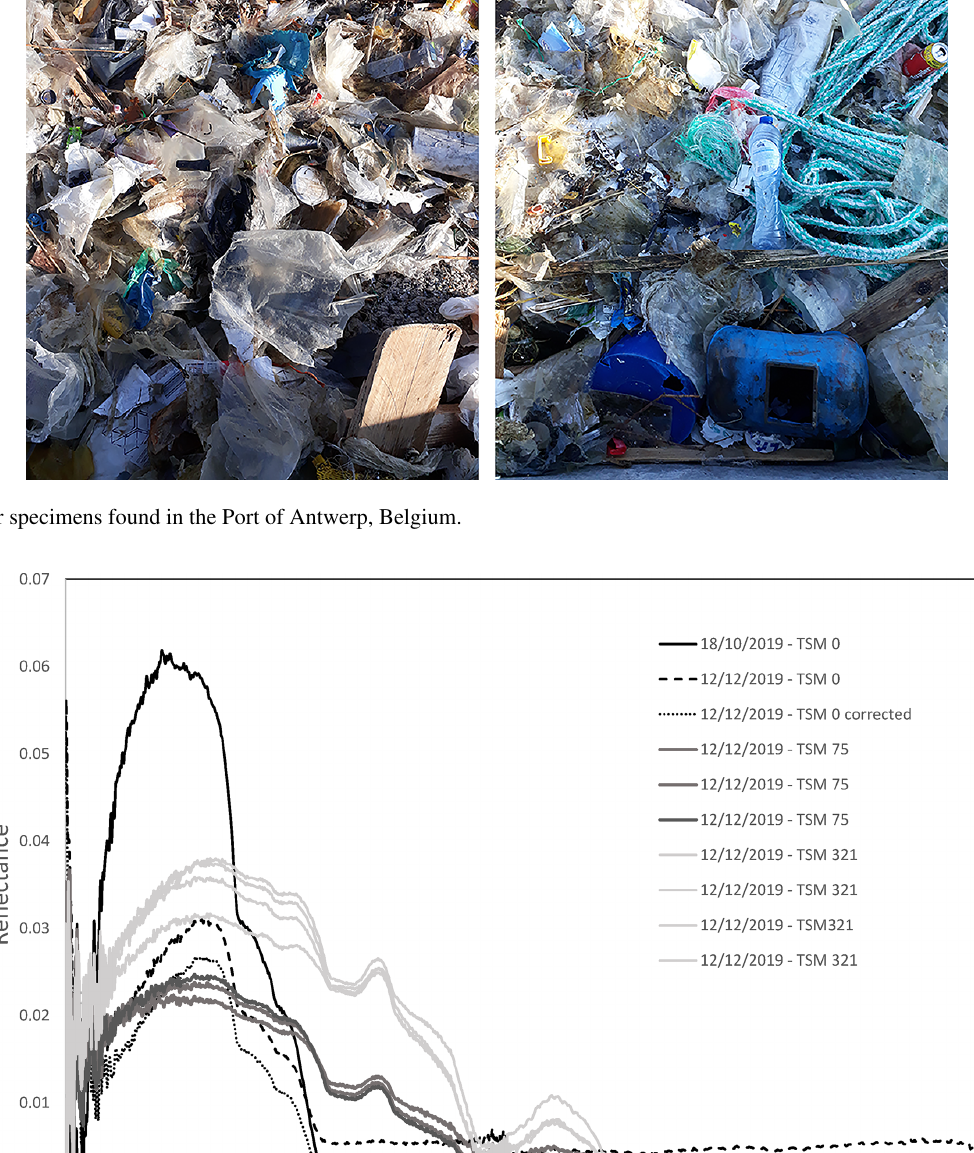
measured on two dates: 18 October 2019 and 12 Decem- ber 2019. Both water spectra are shown in Fig. 4 by a black and dashed black line. In the visible region, the tank water measured on 18 October has a higher reflectance than the tank water measured on 12 December. In the near-infrared